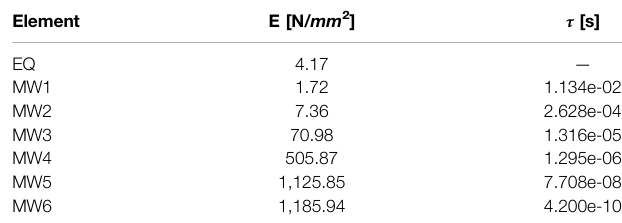
TABLE 1 | Adopted constitutive parameters of a styrene-butadiene rubber (SBR) material (Wriggers and Reinelt, 1996).